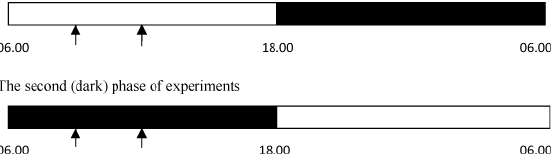
Scheme 1. Adaptation of rats to the light-dark cycle 12 hours:12 hours in a special room (humidity 50 – 60%, temperature in cages 24 0C) for 4 weeks. Light part of the day – empty stripes; dark part of the day – black stripes. Arrows indicate the running time of the